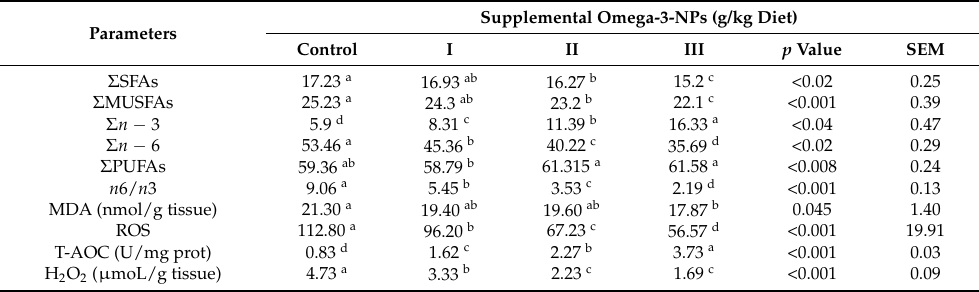
Table 5. Meat fatty acid analysis, lipid peroxidation and antioxidant biomarker of Nile tilapia ( O. niloticus ) fed diets enriched with various levels of omega-3-NPs.